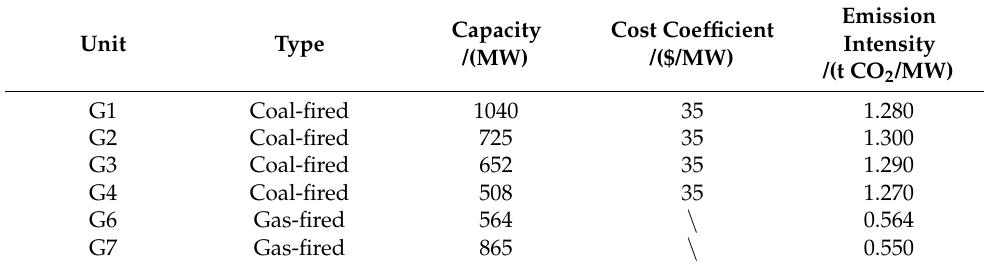
Table 2. Parameters of the natural gas sources.